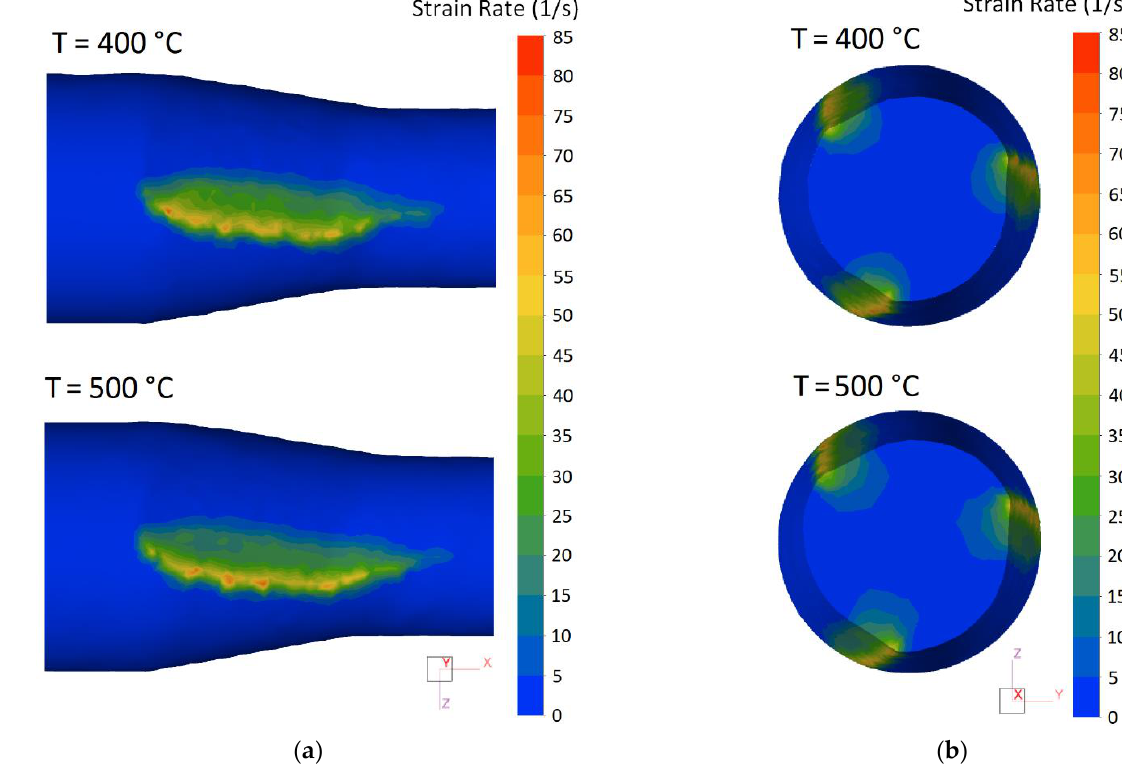
Figure 7. The field of strain rate distribution ( a ) on the surface of the workpiece in contact with roll and ( b ) in the cross section of the pitch point of the deformation zone.